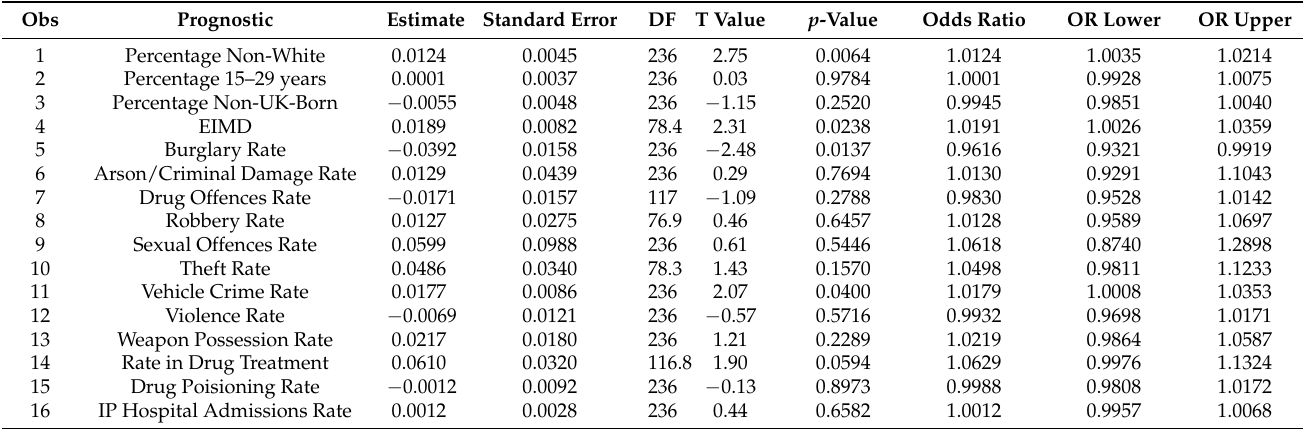
Table 3. Population-averaged fixed effects modeled to the rate of public perceptions of drug use in London, Odds Ratios (OR).